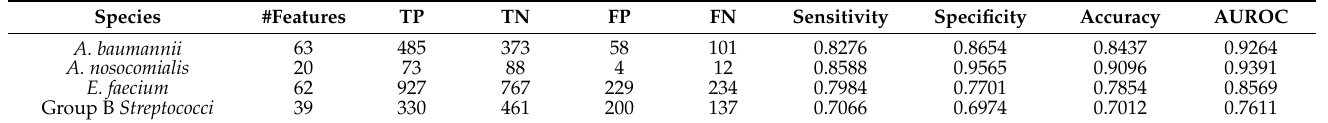
Table 2. Performance of different species using ensemble method preprocessing and RF with selected features on the independent testing